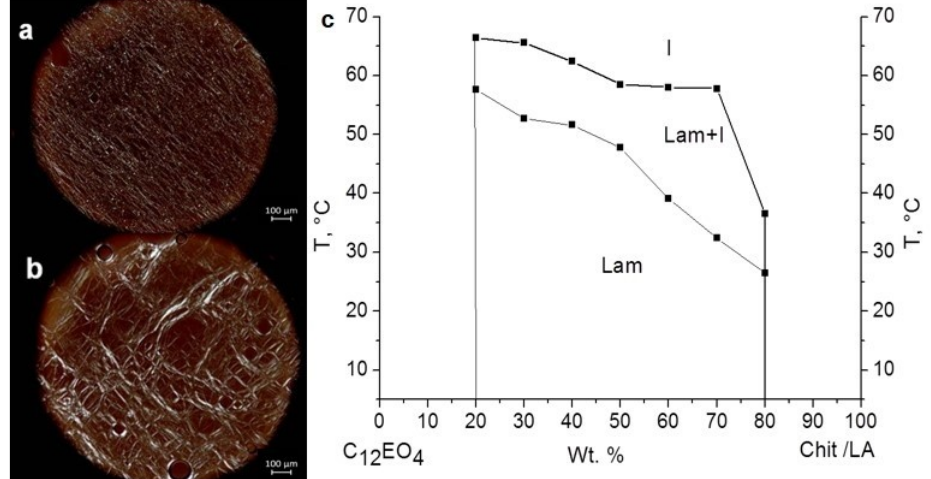
Figure 2. POM images of C 12 EO 4 /(Chit:LA) at C 12 EO 4 : ( a ) 70 wt. %; ( b ) 30 wt. %; ( c ) phase diagram of the C 12 EO 4/